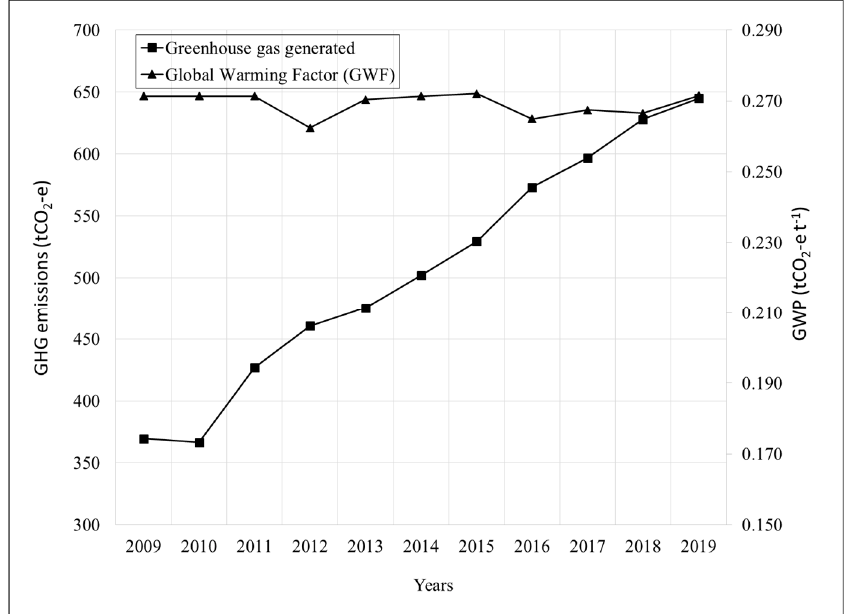
Figure 3. The amounts of greenhouse gases (GHG) versus the global warming factor (GWF) generated during the transportation and treatment of biomedical waste from 2009 to 2019.